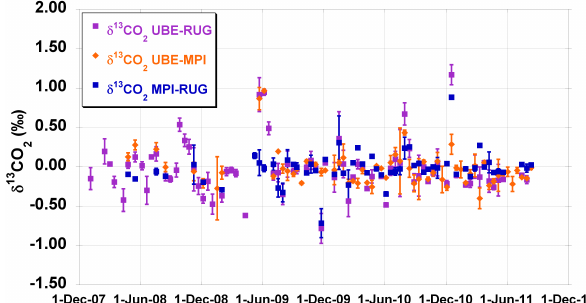
Fig. 7. Differences of the δ 13 CO 2 values measured by each pair of two laboratories. The average differences are: − 0.03‰ for UBE- RUG, − 0.02‰ for UBE-MPI and − 0.02‰ for MPI-RUG. The error bars represent the quadratically added standard errors of the measurements of the two